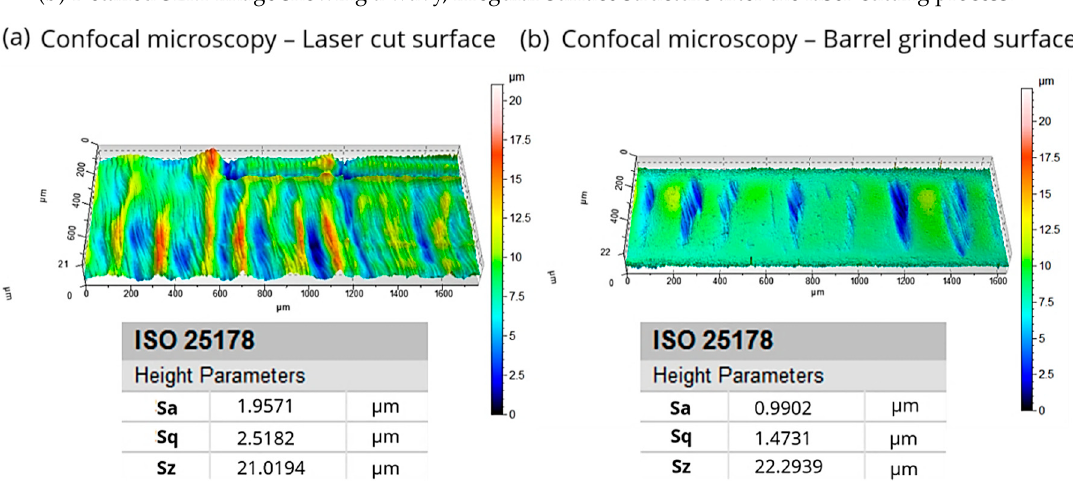
Figure 3. Typical representative surface reliefs by means of confocal microscopy (normalized) of Ti-6Al-4V-ELI with average height parameters: ( a ) Surface after laser-cutting; ( b ) Surface after bar- rel-grinding—Improvement of surface